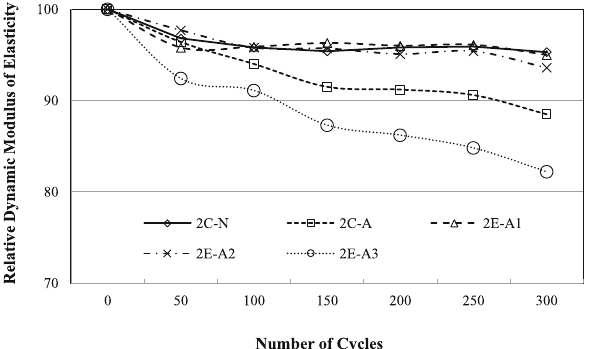
Fig. 10 Effect of mix proportioning method on the freeze– thaw resistance for mix series